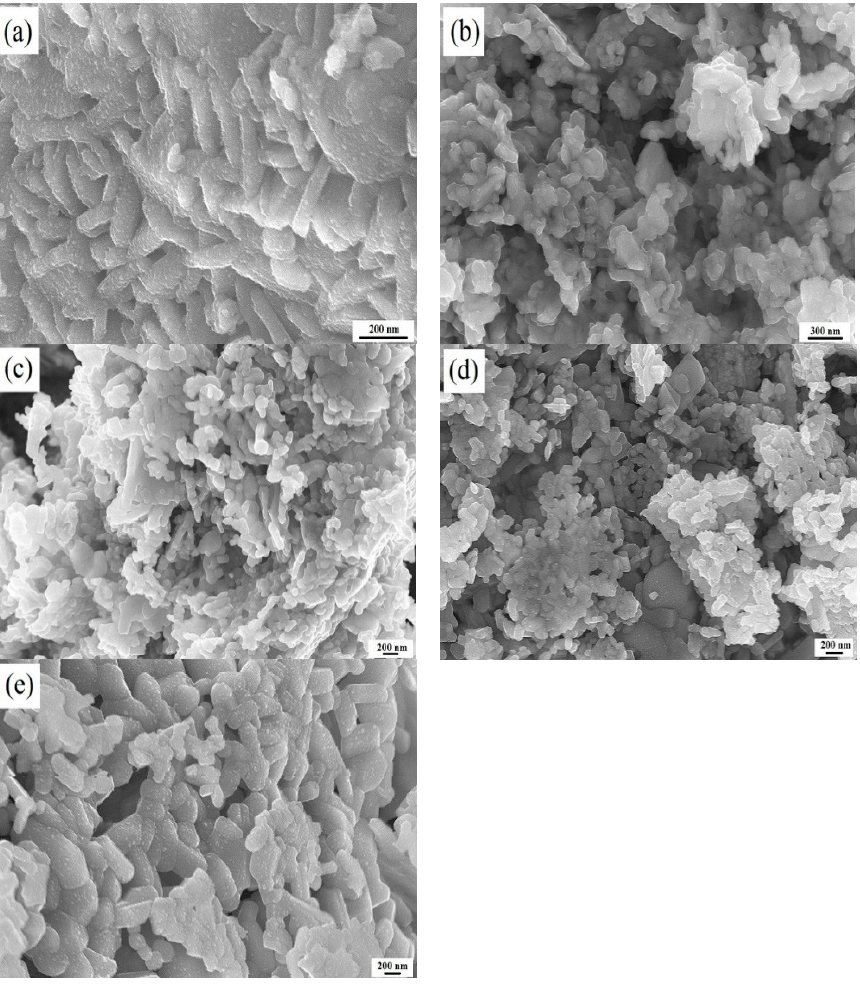
Figure 4. SEM images of products obtained at different annealing temperatures: ( a ) 700 °C; ( b ) 800 °C; ( c ) 900 °C; ( d ) 1000 °C; ( e ) 1100 °C.